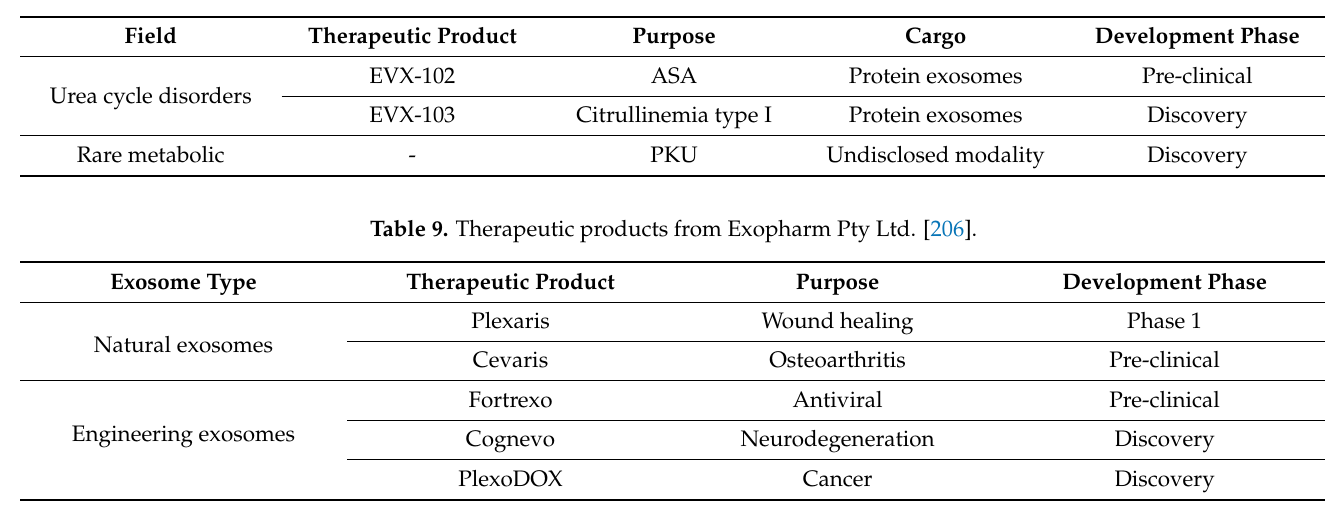
Table 8. Exosome-based therapeutics from Evox Therapeutics [202].